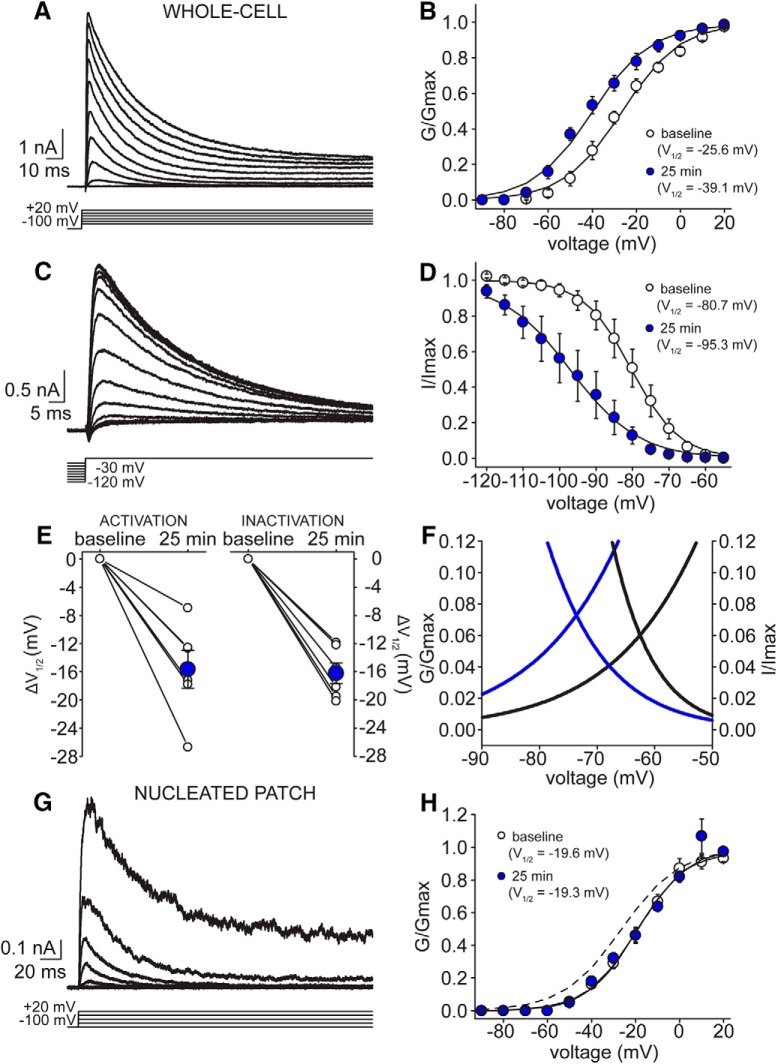

IA exhibits shifts in both activation and inactivation during 25-min recording. A, Example voltage-clamp traces of IA currents at baseline during activation protocol (patch #171024p3). B, Summary plot of voltage dependence of activation of IA at baseline (white circles) and after 25 min of recording (blue circles; n = 7 cells). C, Example voltage-clamp traces of IA currents evoked during inactivation protocol (patch #171127p3). D, Summary plot of voltage dependence of inactivation of IA at baseline (white circles) and after 25 min of recording (blue circles; n = 7 cells, same as in B). E, Normalized V1/2 activation (left) and inactivation (right) compared to delta shift after 25-min recording for each cell (white circles), along with summary mean delta for each measure (blue circles). F, Zoom-in of Boltzmann fits for both voltage dependence of activation and inactivation at baseline (black lines) and at 25 min (blue lines) from B, D, respectively, depicting symmetrical translocation of IA window current. G, Example voltage-clamp traces of IA currents during activation protocol observed in a SC nucleated patch (patch #180510p3). F, Summary plot of voltage dependence of activation of IA at baseline (white circles) and 25 min (blue circles; n = 6 patches). Dashed line depicts baseline activation curve measured in whole-cell configuration from B.